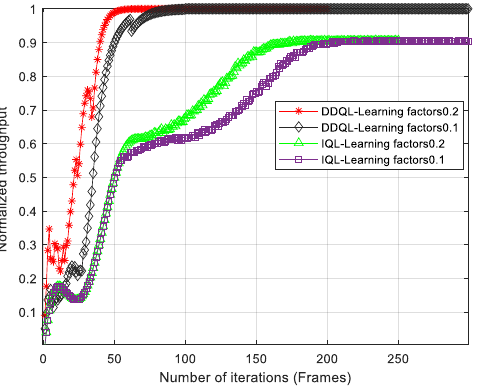
Figure 4. Relationship between normalized throughput and learning factor.